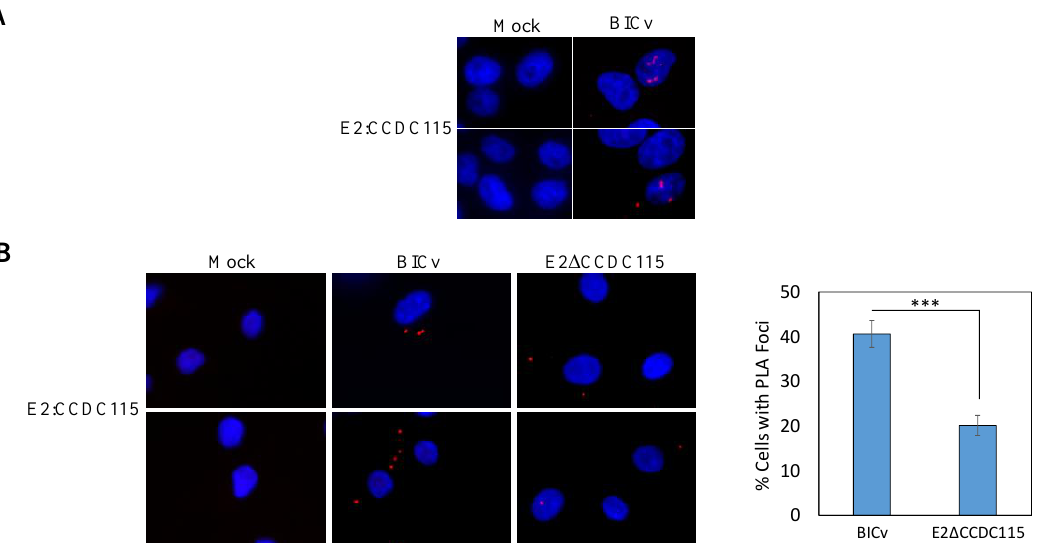
Figure 1. Interaction between CSFV E2 and CCDC115 in CSFV-infected cells demonstrated by proximity ligation assay (PLA). Images were visualized at 40X magnification. SK6 cells ( A ) or primary swine macrophages ( B ) that were either mock infected (Mock) or infected for 24 h with CSFV parental BICv or recombinant E2 ∆ CCDC115v (MOI = 10) as described in Materials and Methods. Panel B (on the right), quantification of the decrease in the E2-CCDC115 interaction in swine macrophages infected with either BICv or E2 ∆ CCDC115v, error bars represent the average and standard deviation from from the counting of three independent counts of 100 cells. *** p -value <